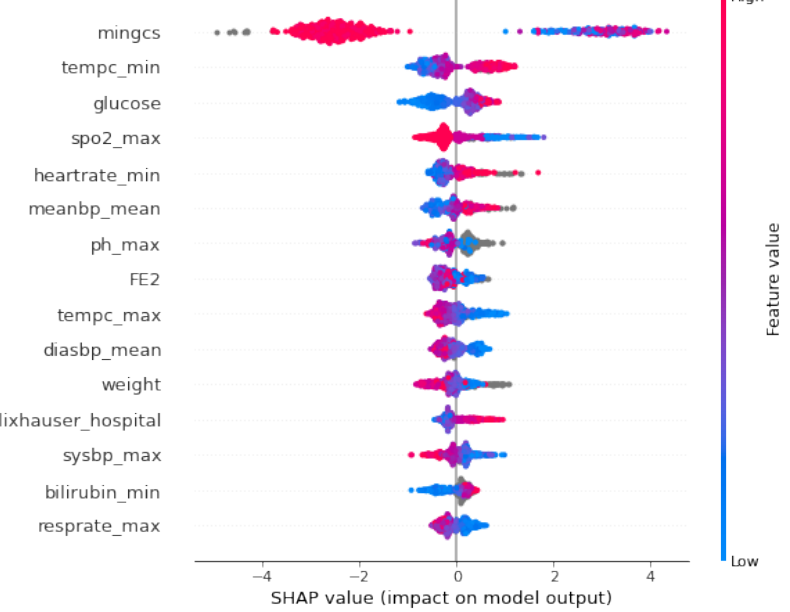
Figure 13. SHAP bee swarm plot for XGBoost